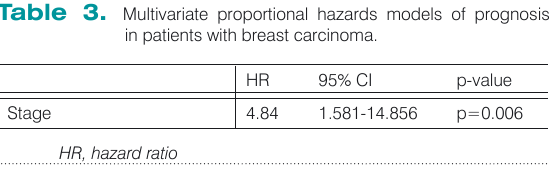
Figure 1. The effect of neopterin levels on overall survival in patients with breast